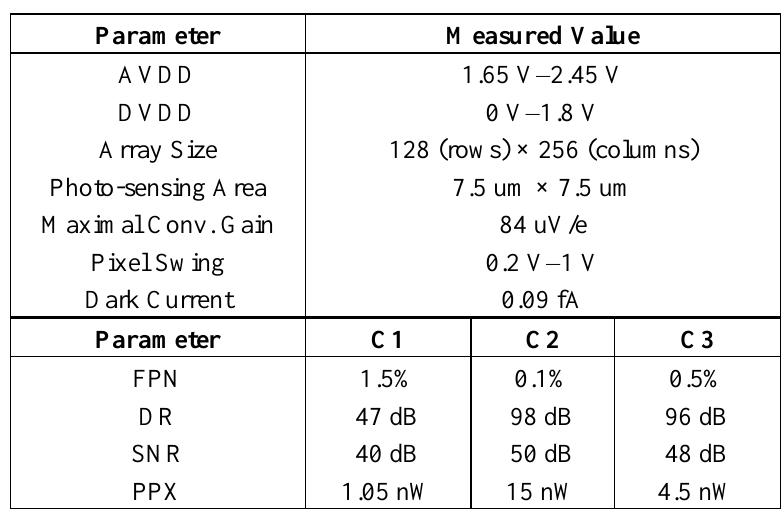
Table 2. Measured sensor